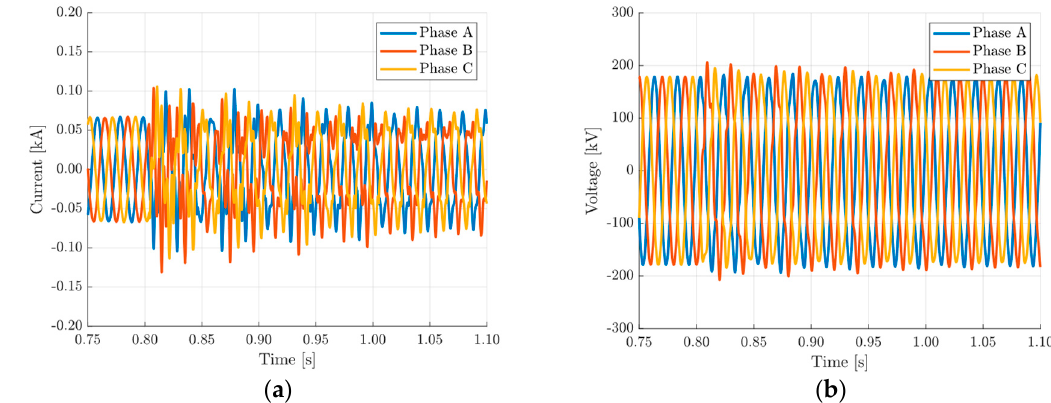
Figure 6. Simulation results with a synchronous generator as the self-start unit in the simplified benchmark system after closing breaker BRK3, thus energising the first offshore transformer: current ( a ) and voltage ( b ) waveforms.